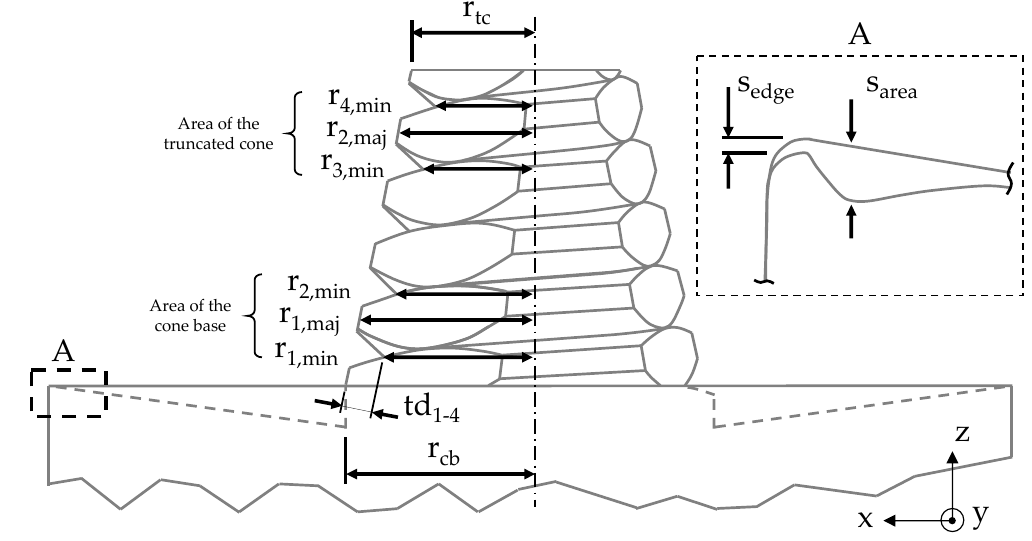
Figure 4. Measuring design with the definition of points measured on the tool.